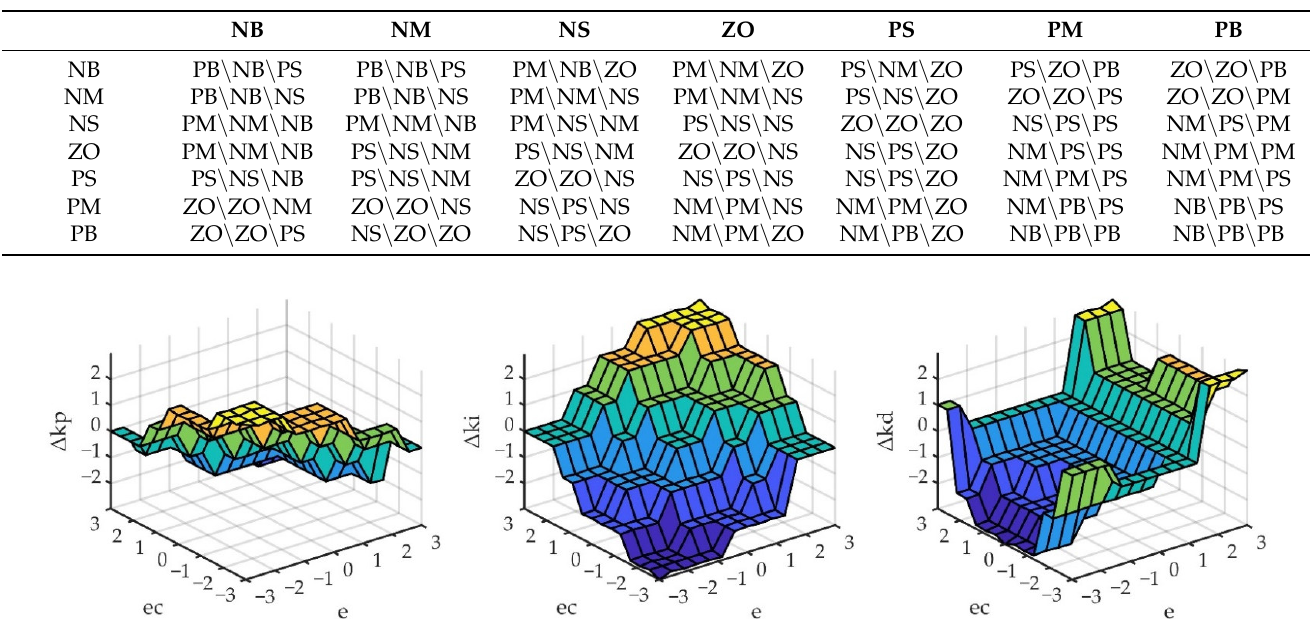
Figure 2. Fuzzy surface of the three correction parameters with fuzzy input.